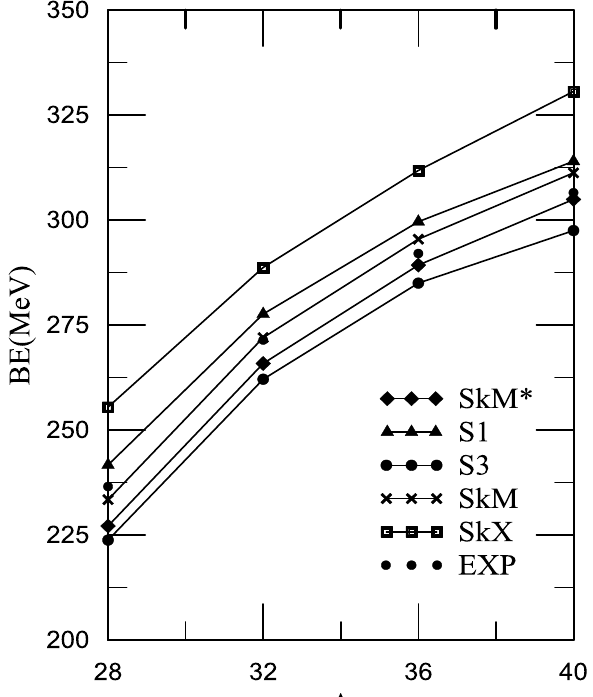
Fig. 8: The binding energy of: Si-isotopes, for different Skyrme interaction set parameters.